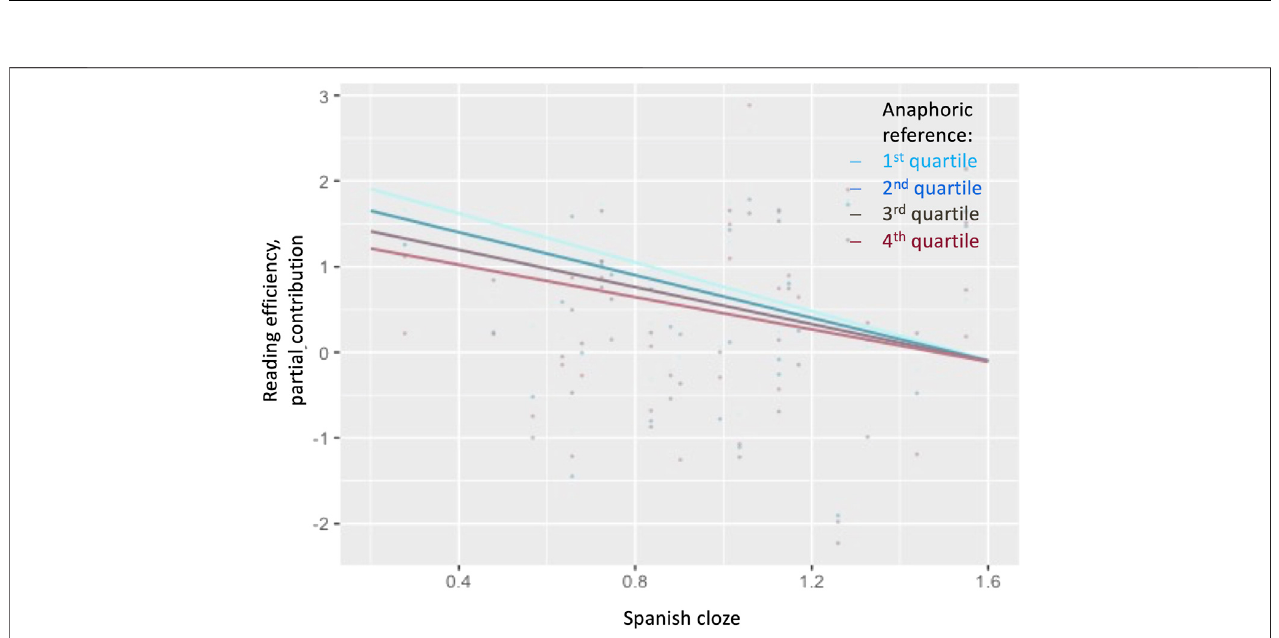
FIGURE 4 | Model 4.3 displaying the relationship of L1 Spanish cloze skills with reading ef fi ciency for different quartiles of anaphoric reference (ns interaction).